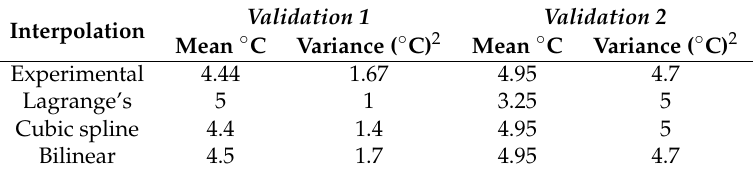
Table 3. Method comparison.